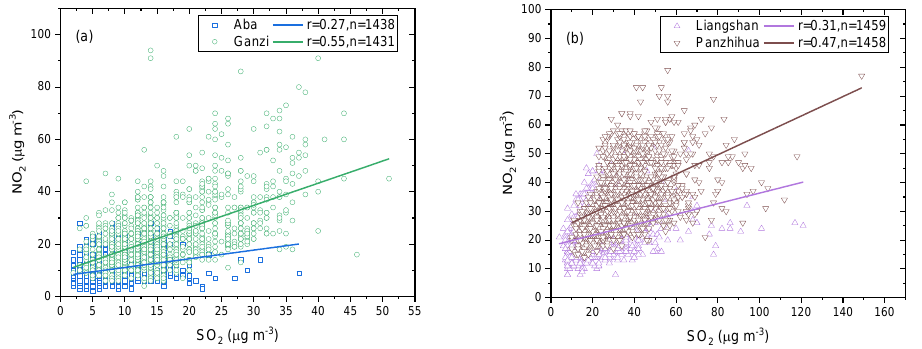
Figure 12. Correlation between SO 2 and NO 2 in the ( a ) ecological zone and ( b ) economic zone in 2015 – 2018.